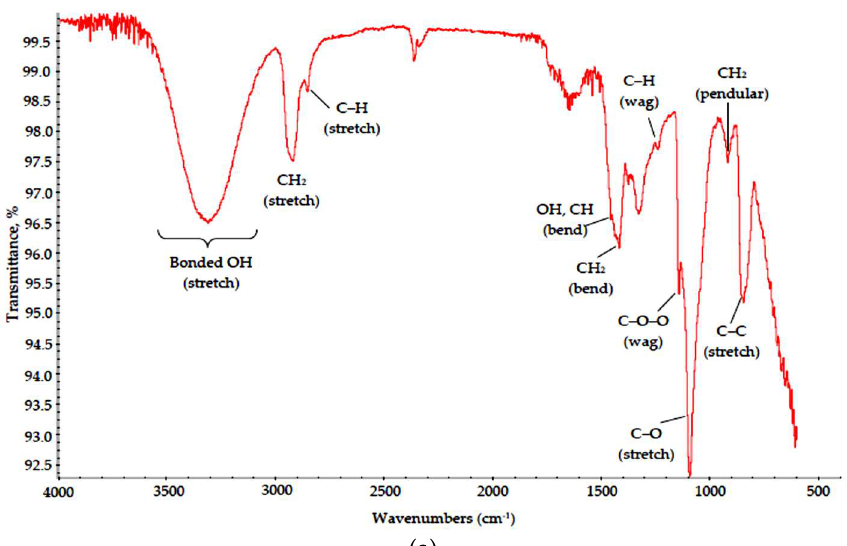
Figure 2. Optical images of ( a ) polyvinyl alcohol (PVA), ( b ) Na-salt of carboxymethylcellulose (Na- CMC), and ( c ) polyvinylpyrrolidone (PVP) dried